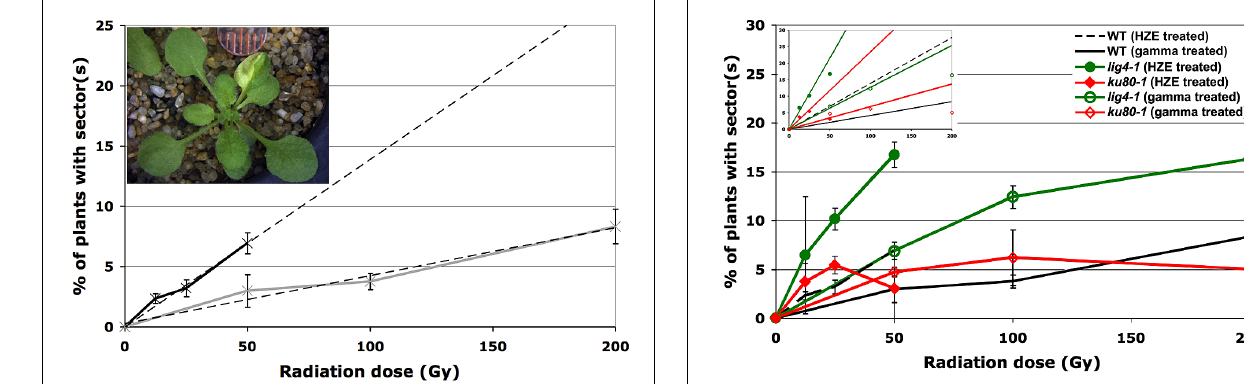
a sector, suggesting a rate of spontaneous LOH per plant for this